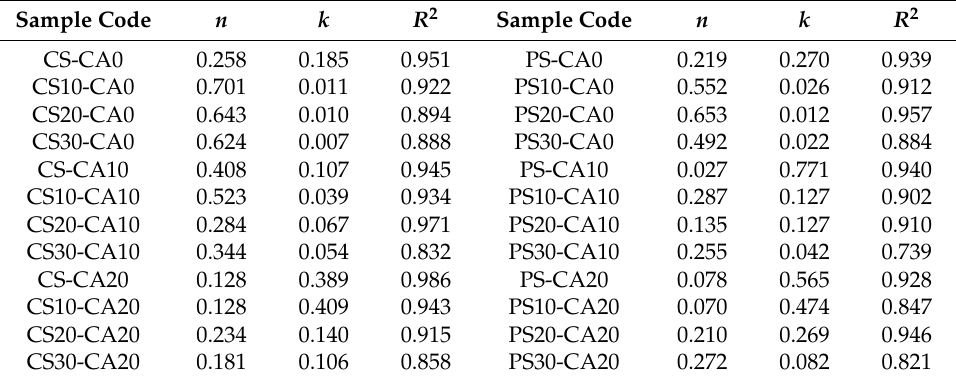
Table 4. The swelling parameters of polysaccharide-based SAPs in the Fickian diffusion model. Sample